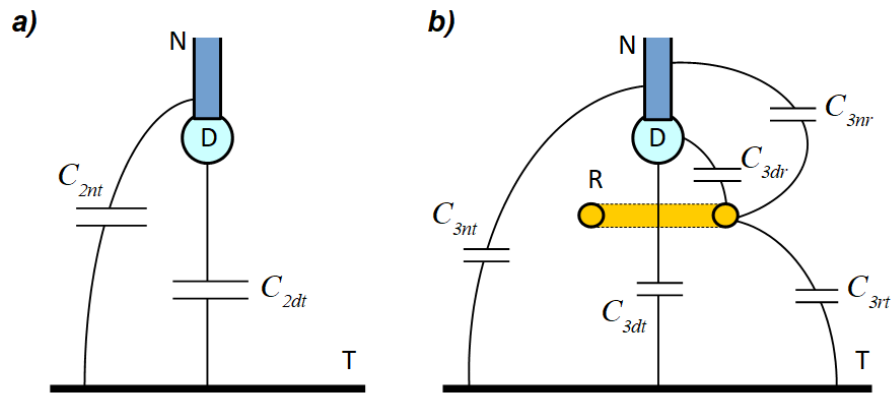
Figure2. Capacitancedistributionina( a )2-electrodesystemand( b )3-electrodesystem. Note: T—target; Figure 2. Capacitance distribution in a ( a ) 2-electrode system and ( b ) 3-electrode system. Note: T — R—ring electrode; D—droplet; N—nozzle; C 2 nt —capacitance between nozzle and target in a 2-electrode target; R — ring electrode; D — droplet; N — nozzle; C 2 nt — capacitance between nozzle and target in a 2- system; C 2 dt —capacitance between droplet and target in 2-electrode system; C 3 nt —capacitance between electrode system; C 2 dt — capacitance between droplet and target in 2-electrode system; C 3 nt — nozzle and target in a 3-electrode system; C 3 nr —capacitance between nozzle and ring electrode in capacitance between nozzle and target in a 3-electrode system; C 3 nr — capacitance between nozzle and a 3-electrode system; C 3 dr —capacitance between droplet and ring electrode in a 3-electrode ring electrode in a 3-electrode system; C 3 dr — capacitance between droplet and ring electrode in a 3-